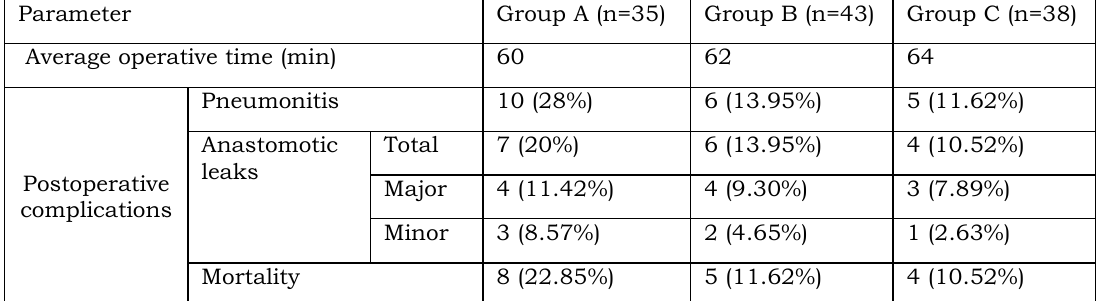
Table 2 Comparison in terms of operative time and postoperative